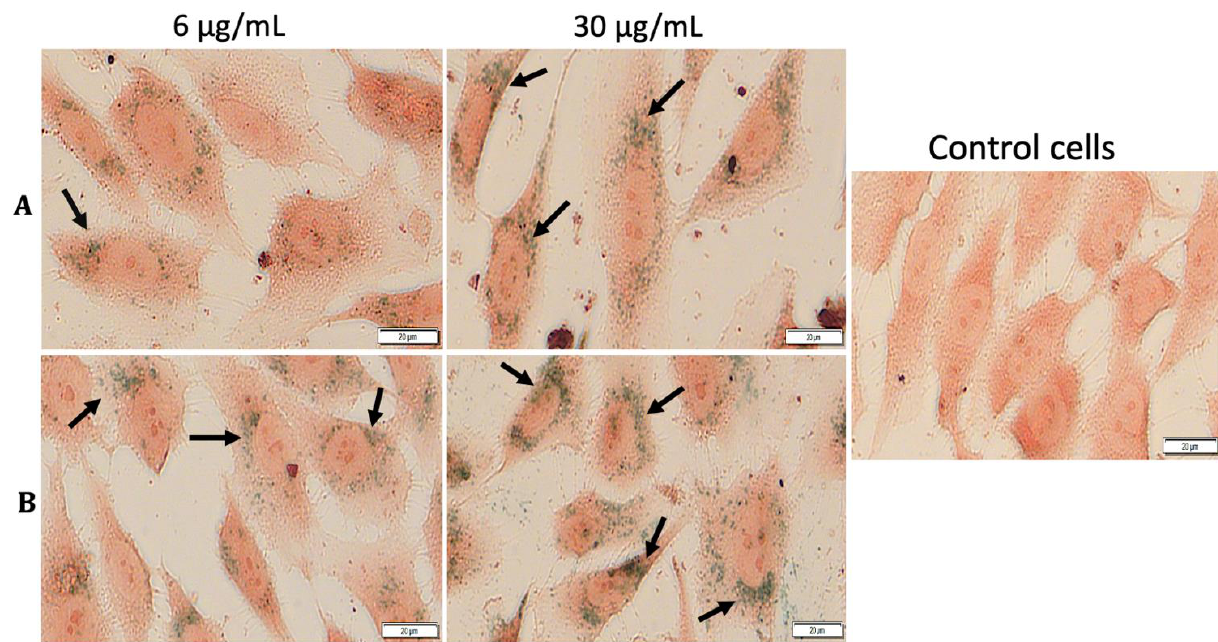
Figure 16. Cellular internalization of MCS within MCF-10A cells under standard ( A ) and hyperthermic conditions ( B ). The cells were visualized under bright field microscopy at a magnification of 40×. Scale bars represent 20 µm.